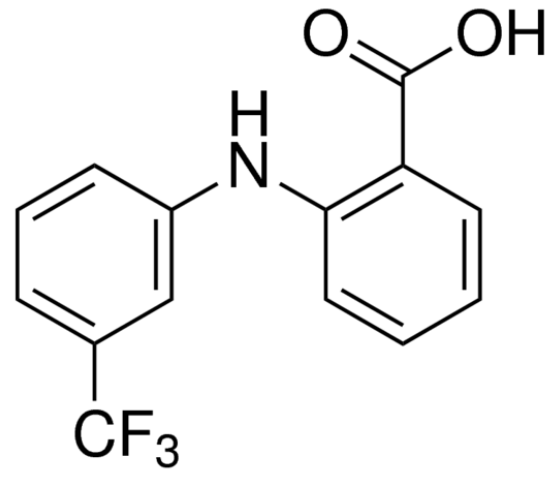
Figure 1. Chemical structure of flufenamic acid (FFA).